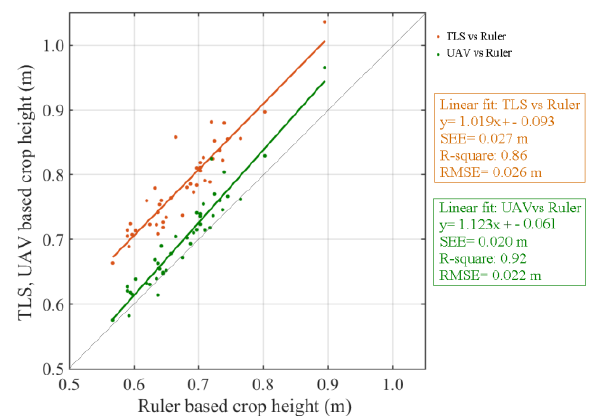
Figure 10. Linear correlation between UAV, TLS and ruler crop